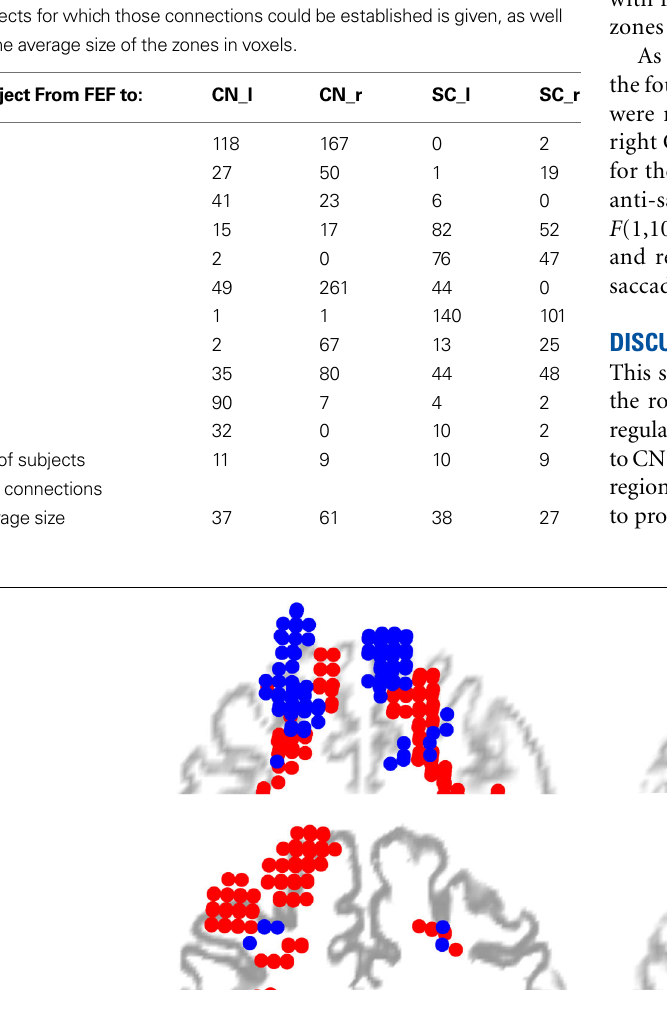
FIGURE 4 | Spatial distribution of FEF voxels connected to the SC (red circles) or to the CN (blue circles), in MNI space, plotted in coronal view for four subjects. The circles are projected to a 2D coronal plane coinciding with a coronal section of the T1 scan normalized to MNI, halfway the selected cluster of